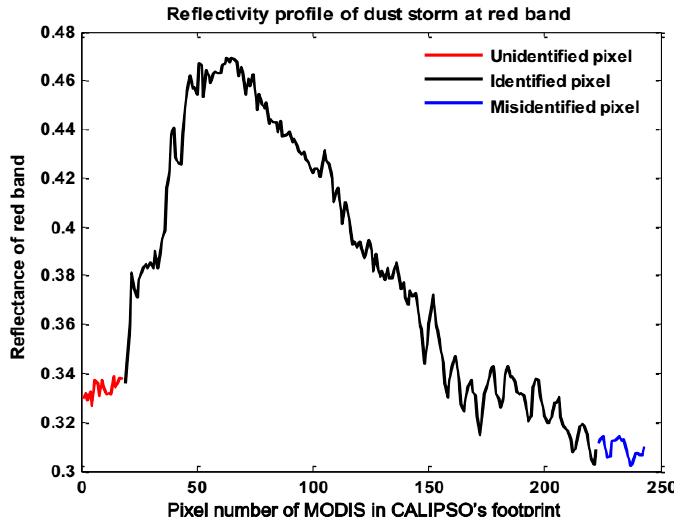
Figure 13. The profile of dust storm in the CALIOP motion direction shown in Figure 10.